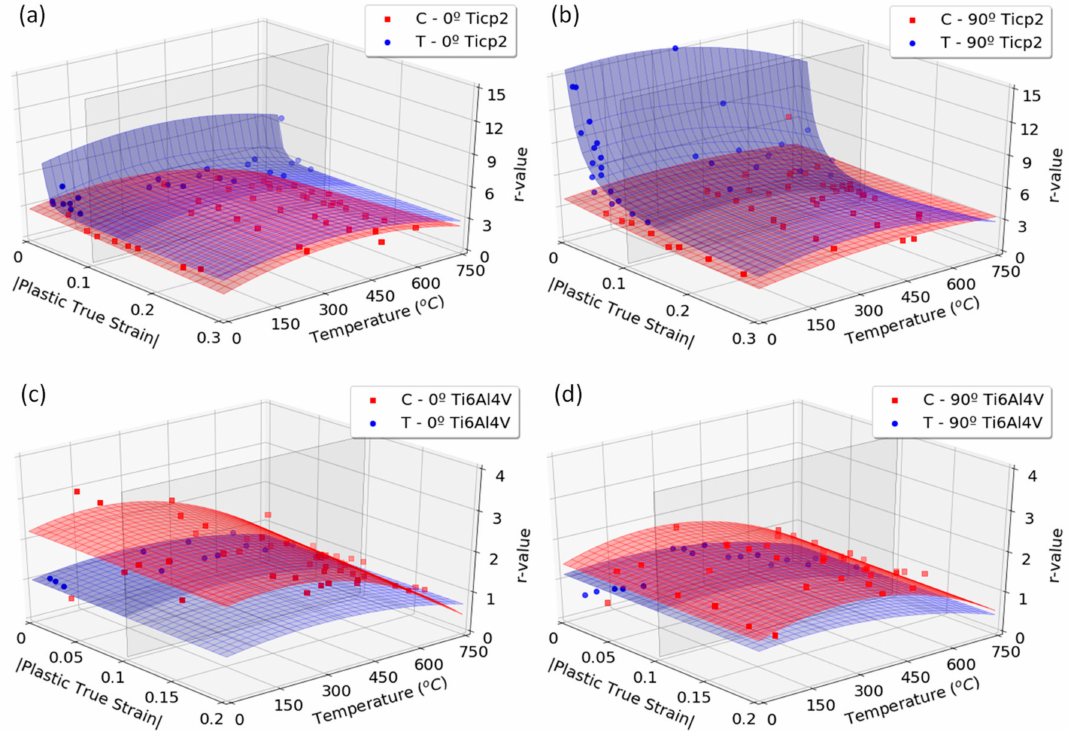
Figure 15. r-values obtained at 0.002 s − 1 under tension (T) and compression (C) conditions. ( a ) Ticp2 0 ◦ ; ( b ) Ticp2 90 ◦ ; ( c ) Ti6Al4V 0 ◦ ; and ( d ) Ti6Al4V 90 ◦